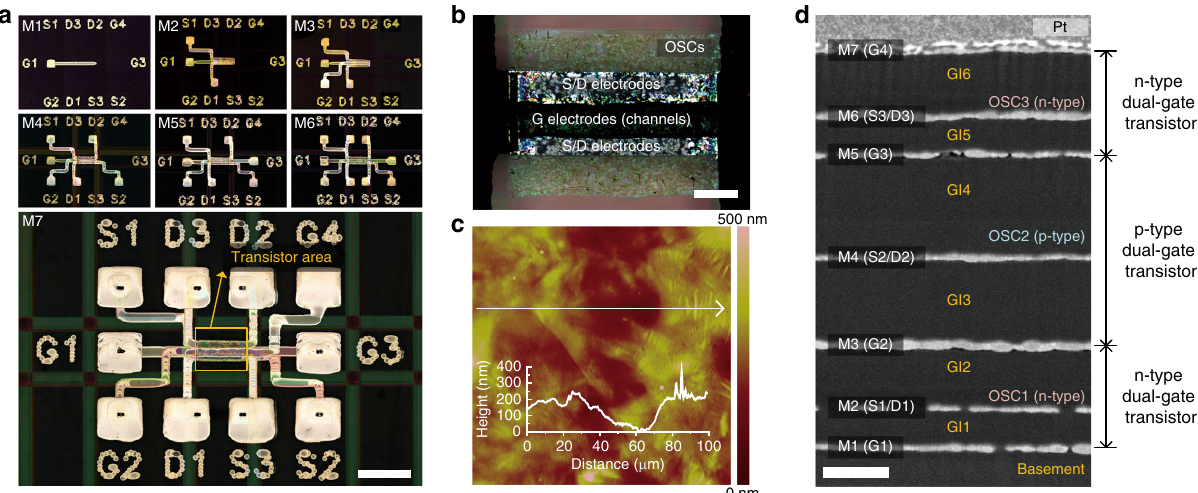
Fig. 2 Images of a stacked 3-T device. a Sequential images of the process of printing seven metal layers (scale bar is 1 mm). b A polarized microscopy image of the transistor area (scale bar is 200 μ m). c A topographic AFM image (scan area is 100 × 100 μ m) measured on top of the channel area. The inset graph shows the pro fi le along the cross-section line. d Cross-sectional SEM image of the stacked 3-T device (M1-7: metal layers, GI1-6: dielectric insulator layers, OSC1-3: organic semiconductor layers, scale bar is 250 nm, Pt was sputtered on the top prior to the SEM